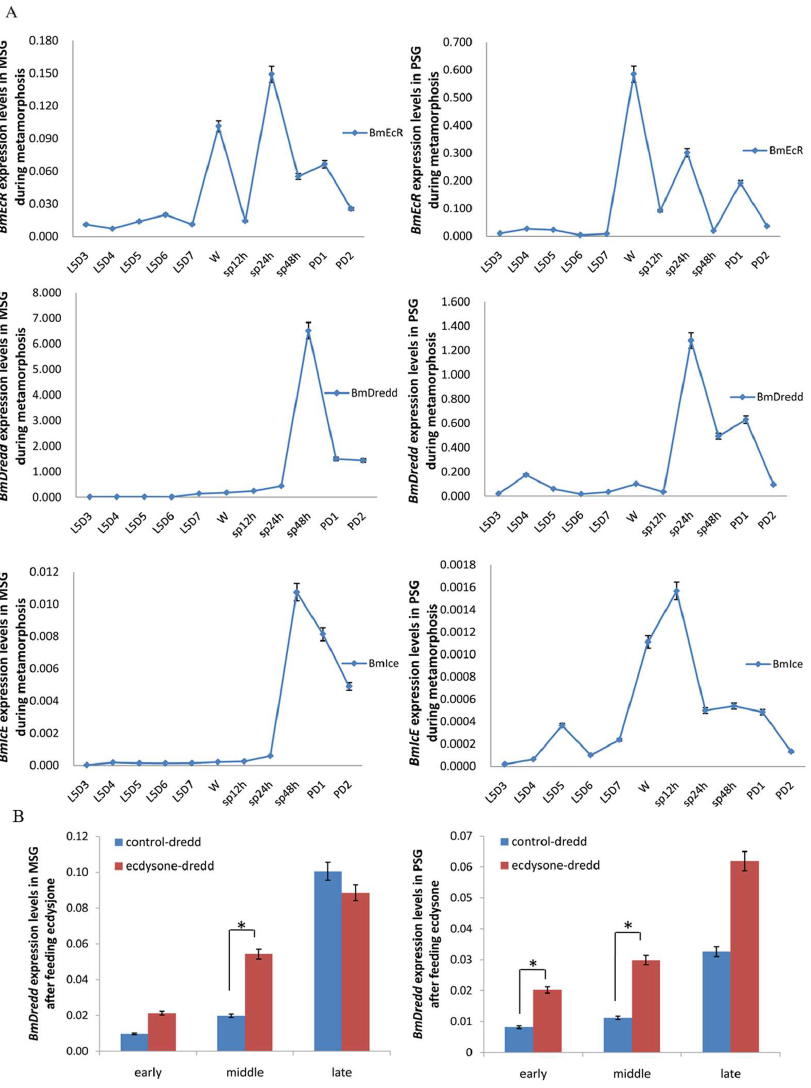
Fig 1. Expression level interactions between BmDredd and other two apoptosis-related genes in MSG and PSG during metamorphosis. (A) Expression levels in MSG and in PSG. L5D3-L5D7: day 3 to day 7 of the fifth larval instar. W: wanderingstage. sp12h: 12 h of spinning.PD1: 1-day-oldpupa. PD2: 2-day-old pupa. (B) The increaseof BmDredd expressioninducedby ecdysonein MSG and PSG, P < 0.5. Early, middleand late means the time of feedingecdysone at L5D3, L5D5 to L5D6 and L5D7 to wandering respectively.